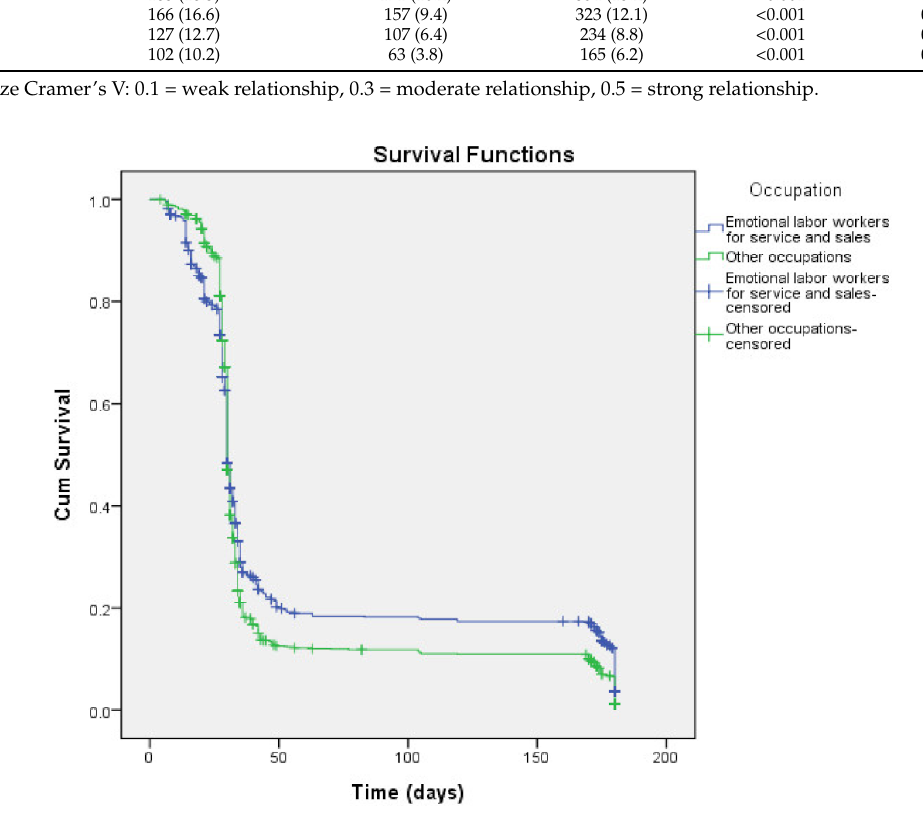
Figure 1. Comparison of Kaplan–Meier survival curves according to occupation ( p = 0.003). Table 3. Supporters of quitting smoking (multiple